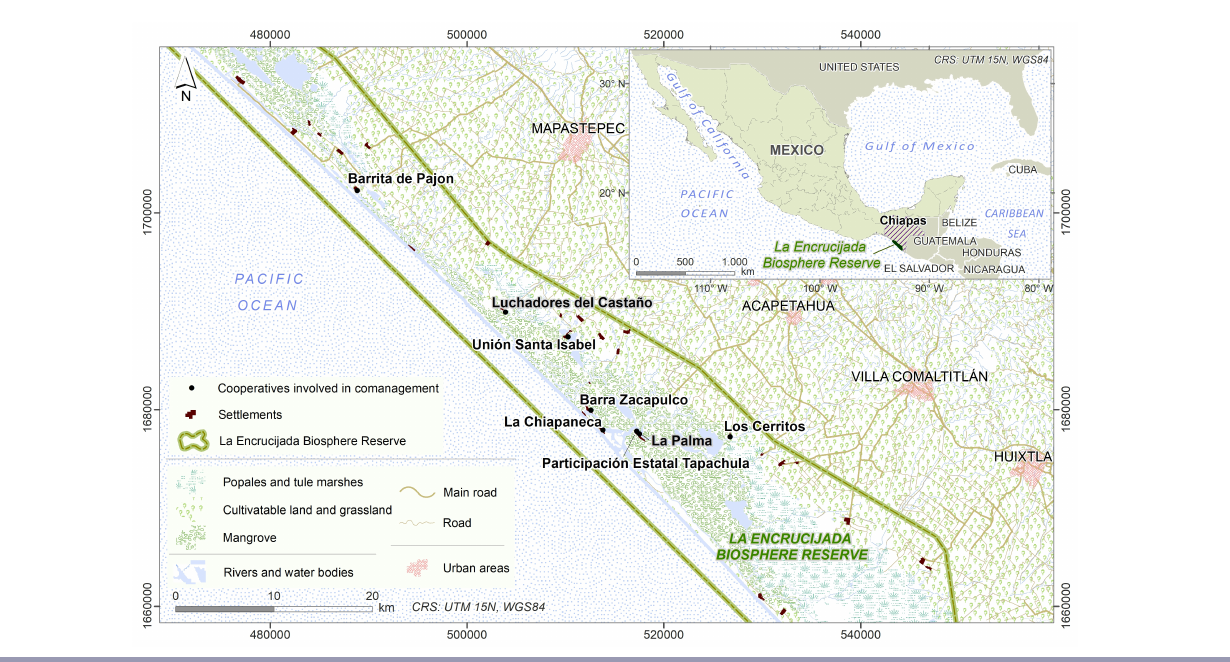
Fig. 1 . Location of La Encrucijada Biosphere Reserve and the cooperatives participating in comanagement. Sources: GADM the Database of Global Administrative Areas (https://gadm. org/), Gobierno del Estado de Chiapas: Geoweb Chiapas 3.0 (http://map.ceieg.chiapas.gob.mx/ geoweb/), Comisión Nacional de Áreas Naturales